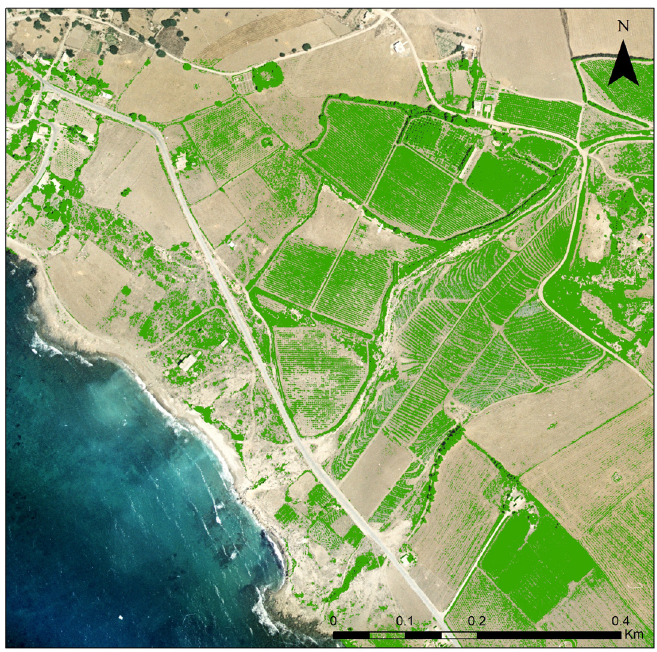
Figure 4: Arable areas and dense vegetation zones within the Eastern necropolis of Nea Paphos are shown in green colour.